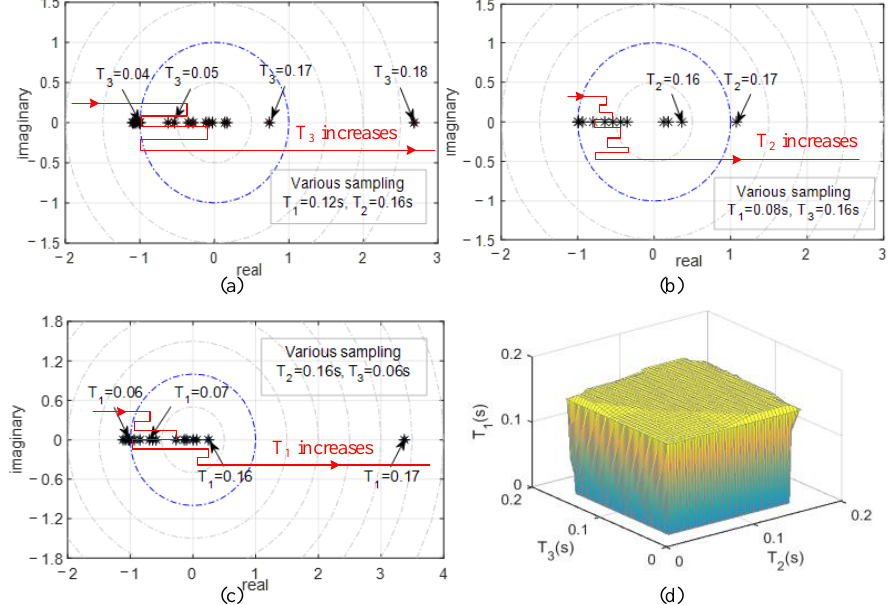
Figure 7. ( a ) Evaluation of T 3 when T 1 and T 2 are fixed. ( b ) Evaluation of T 2 when T 1 and T 3 are fixed. ( c ) Evaluation of T 1 when T 2 and T 3 are fixed. ( d ) Stability region of sampling periods for T 1 , T 2